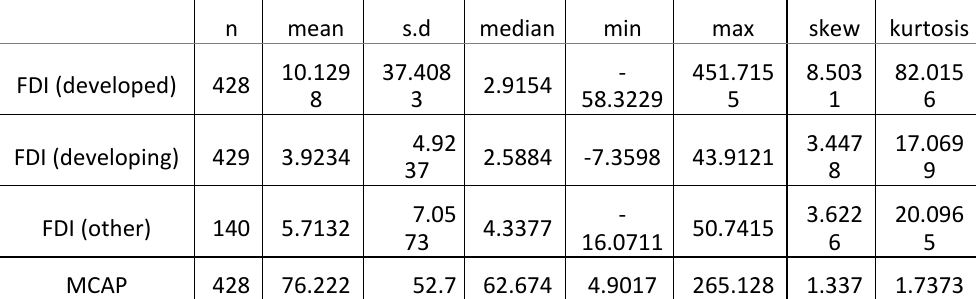
Table 2. Summary statistics: main